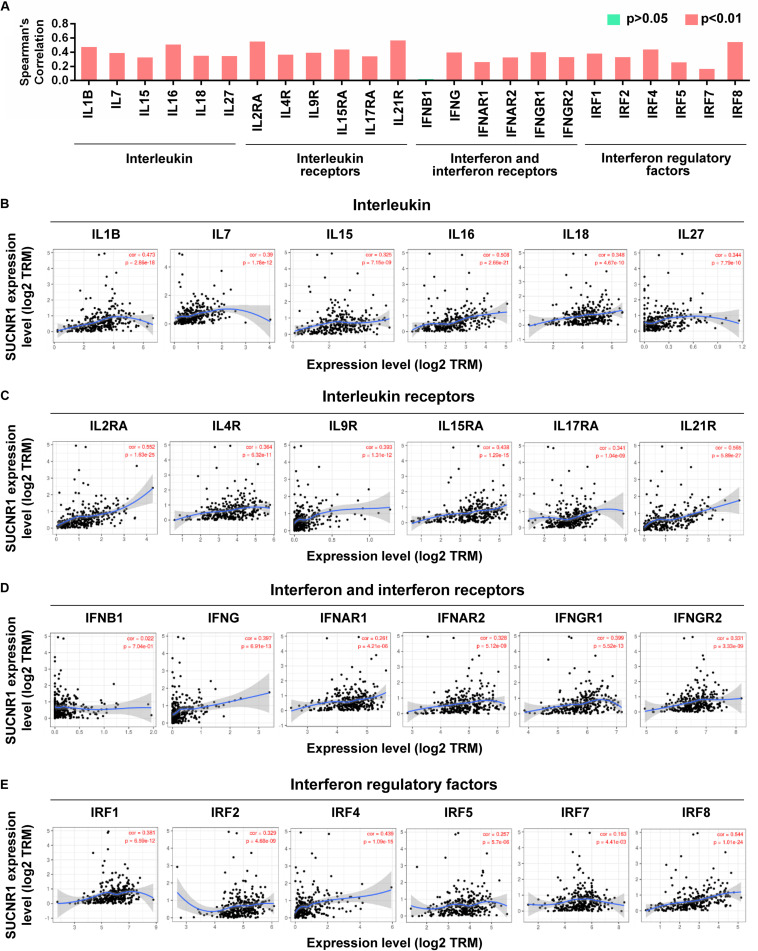
The expression of SUCNR1 is associated with cytokines in ovarian cancer. (A) The summary of the correlation between SUCNR1 and cytokines. (B–E) Correlation of SUCNR1 expression with interleukin, including IL1B, IL7, IL15, IL16, IL18, and IL27 (B), interleukin receptors, including IL2RA, IL4R, IL9R, IL15RA, IL17RA, and IL21R (C), interferon and interferon receptors, including IFNB1, IFNG, IFNAR1, IFNAR2, IFNGR1, and IFNGR2 (D), and interferon regulatory factors, including IRF1, IRF2, IRF4, IRF6, IRF7, and IRF8 (E), in ovarian cancer are available on the TIMER database. Correlation coefficients (rho values) and p values were shown.